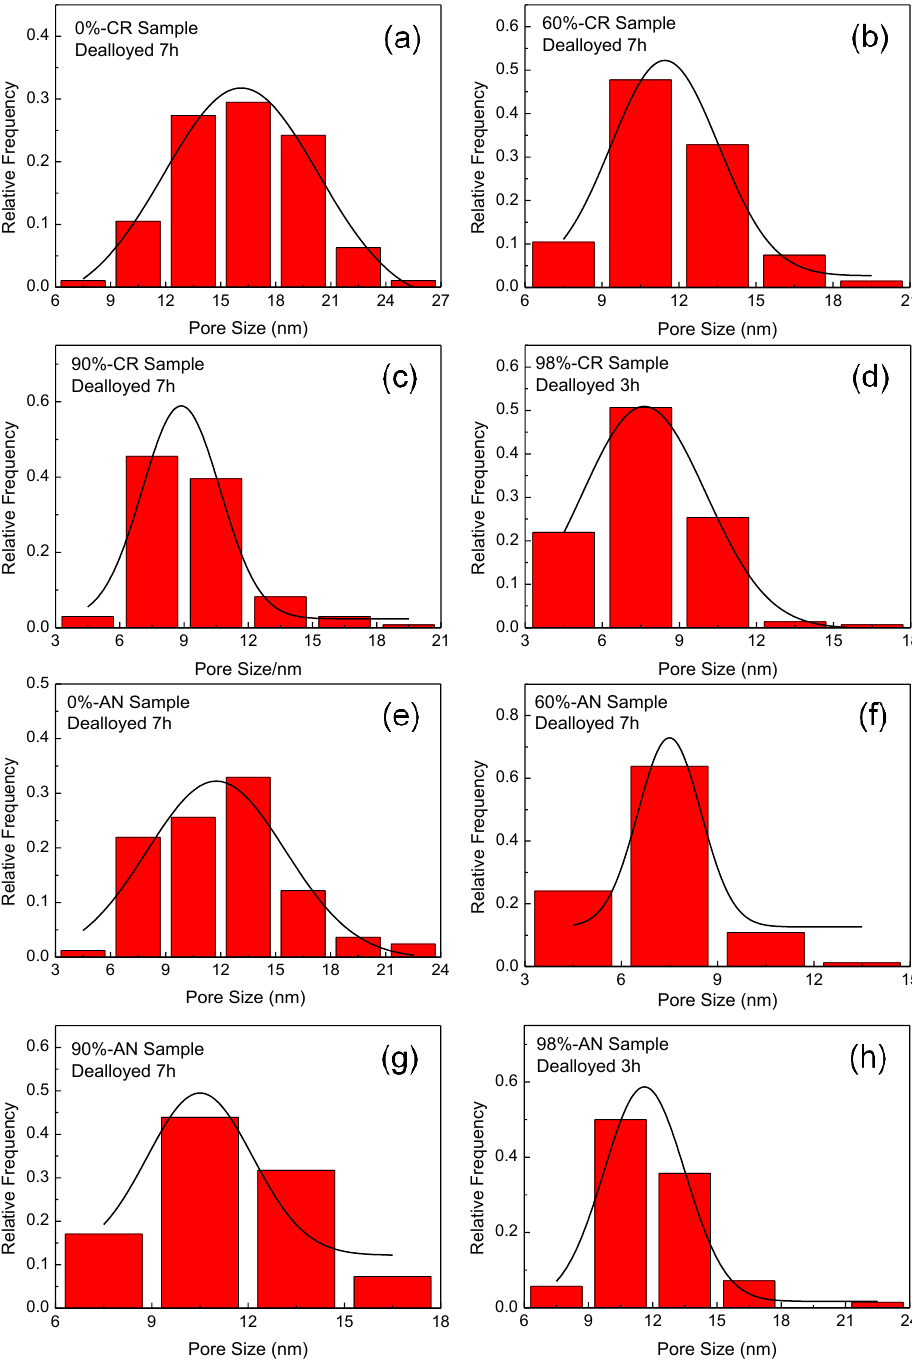
Figure 4. Pore size distribution with corresponding Gauss fit for different samples as indicated. ( a – d ) CR samples with different thickness reductions of 0%, 60%, 90% and 98%, respectively; ( e – h ) AN samples with different thickness reductions of 0%, 60%, 90% and 98%, respectively.